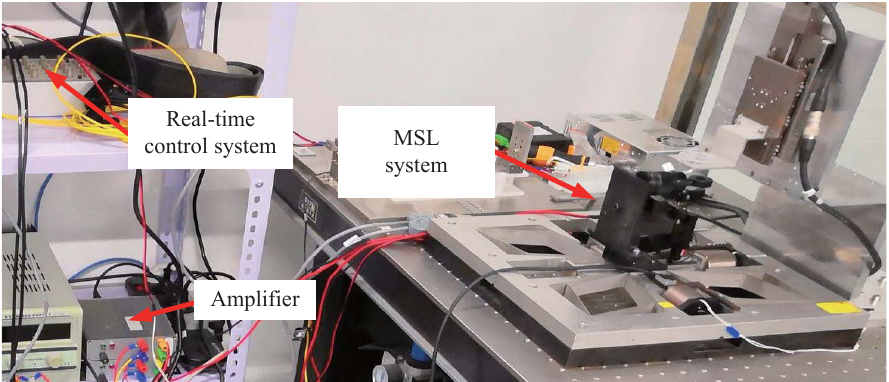
Figure 11. Experimental